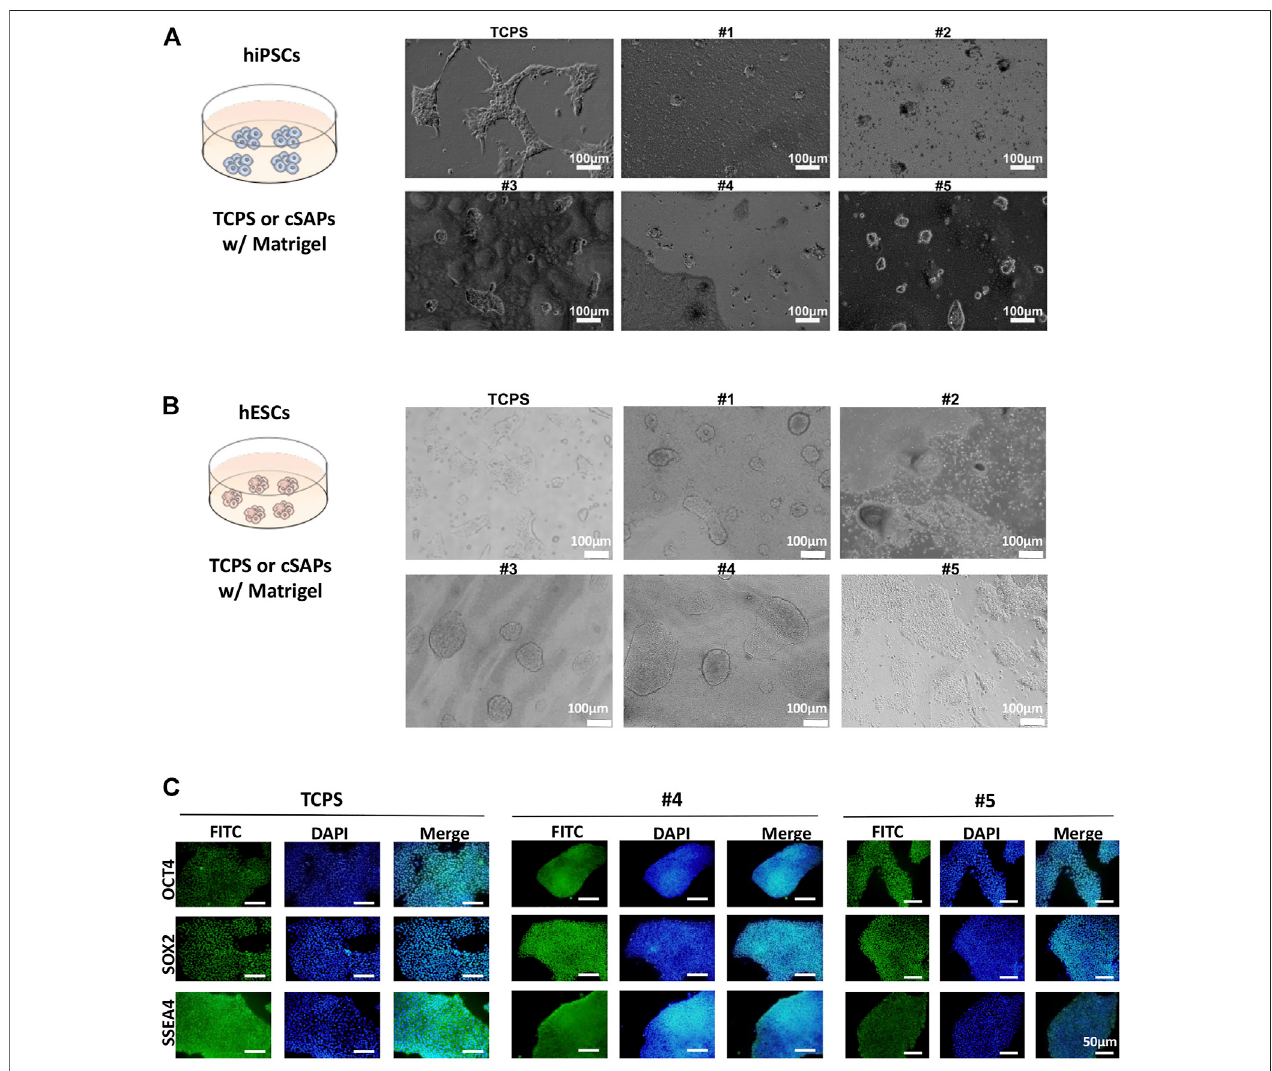
FIGURE 3 | Pluripotency of hiPSCs and hESCs on different substrates coated with Matrigel. Colony morphology of (A) hiPSCs after 3 days and (B) hESCs after three passages cultured on different surfaces. Scale bar (cid:1) 100 μ m. (C) Immunostaining of pluripotent markers (OCT4, SOX2, and SSEA4) of hESCs after three passages ’ culture on cSAPs and TCPS, Scale bars (cid:1) 50 μ